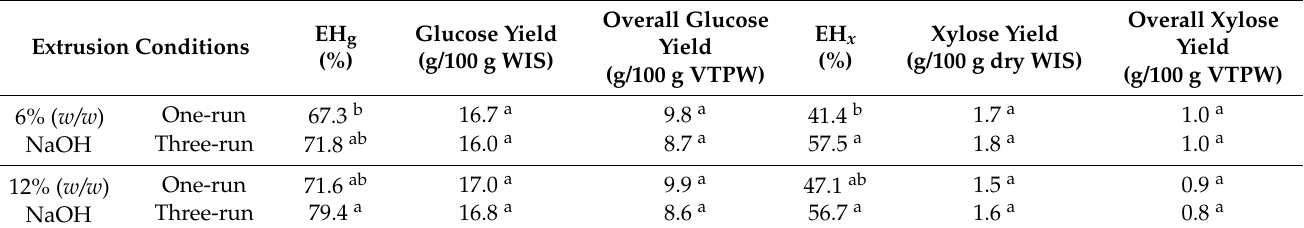
Table 5. Enzymatic hydrolysis yield, glucose and xylose produced by 100 g DW of the water-insoluble solid (WIS) fraction collected after extrusion of vegetal tomato plant waste (VTPW), and overall glucose and xylose yield. Values followed by different letters in the same row are significantly different at the 95% level.